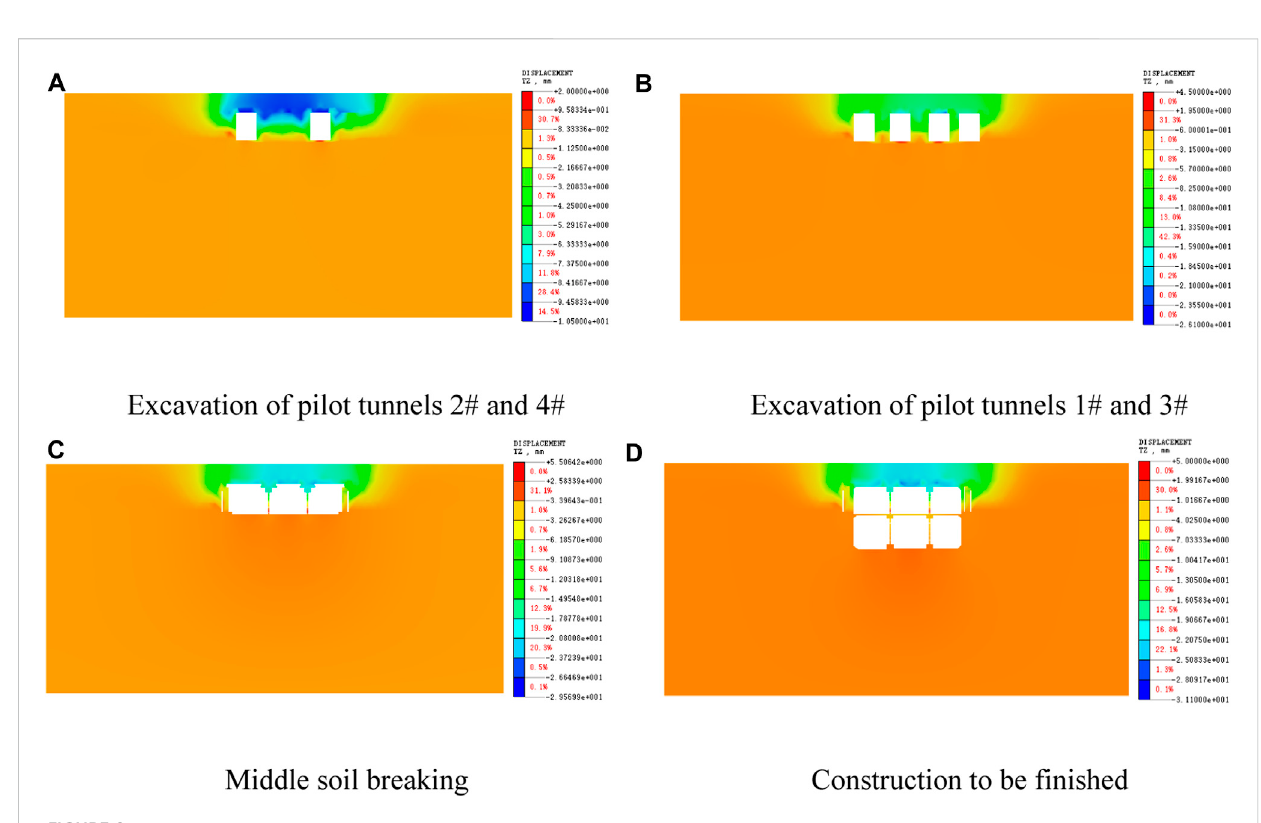
24.9 mm, which is an increase of 4.7 mm, accounting for about 45%of the settlementvalueintheexcavationstagesofpilottunnels2#and4#,andthe maximumsettlementpositionappearsabovepilottunnels2#and3#.After the excavation of the platform layer, the maximum surface settlement is 26.5 mm, an increase of 1.6 mm.